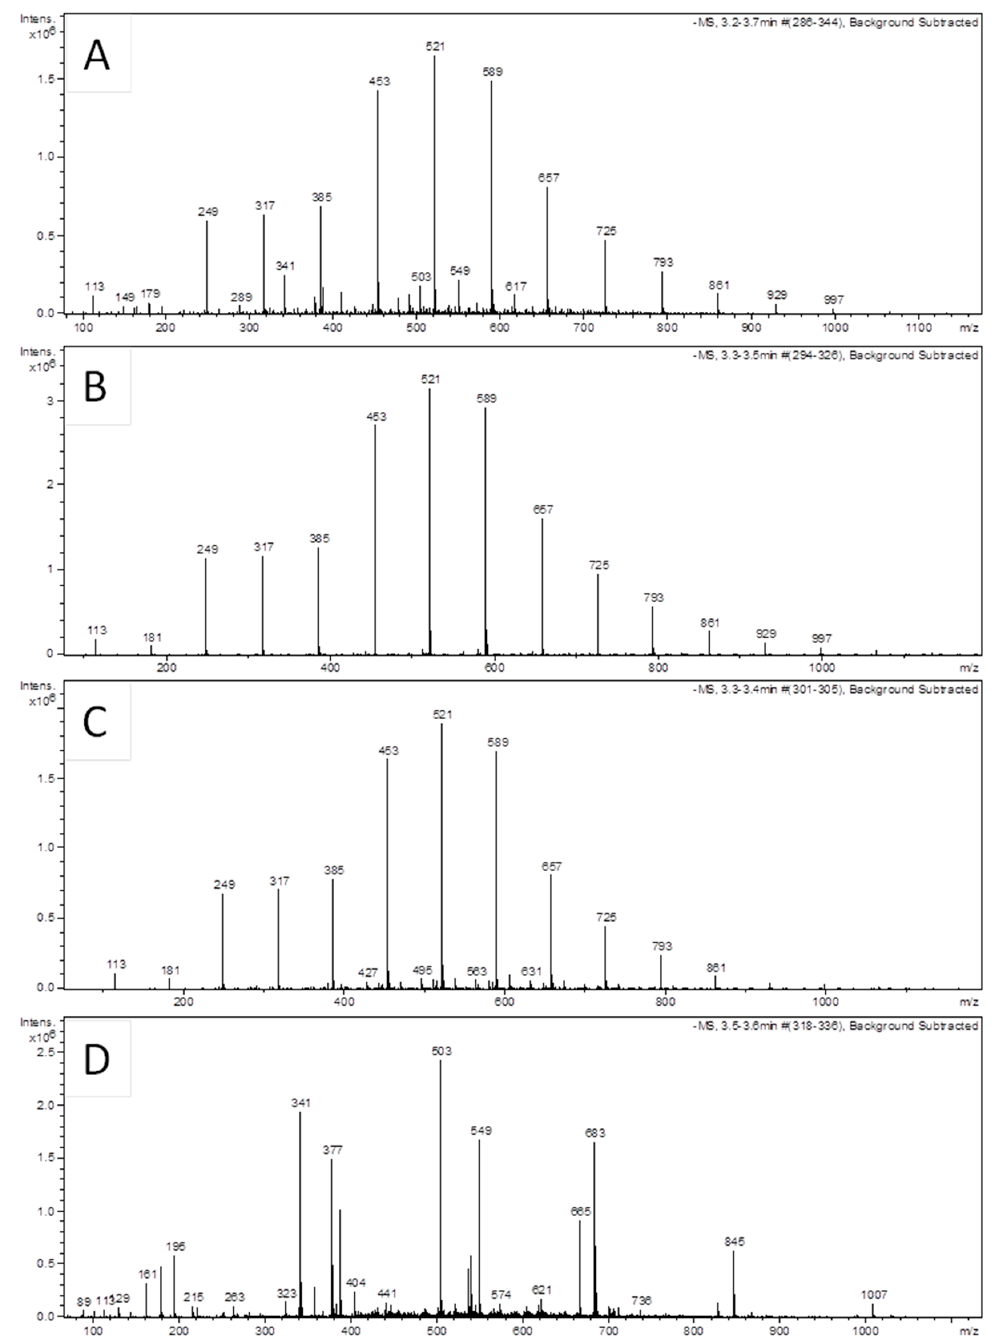
Figure 2. Mass spectra of ubiquinone-like isoprenoid compounds extracted from honey with different solvents and after protein degradation with pronase. ( A ) A full scan mass spectrum of extractives in SN1 removed by a mixture of methanol: ethanol: isopropanol, ( B ) extractives in SN2 after acetone extractions and ( C ) extractives in SN3 after pronase digestion. ( D ) Mass spectrum of extractives present in the supernatant after precipitation of honey with 80% ethanol only.